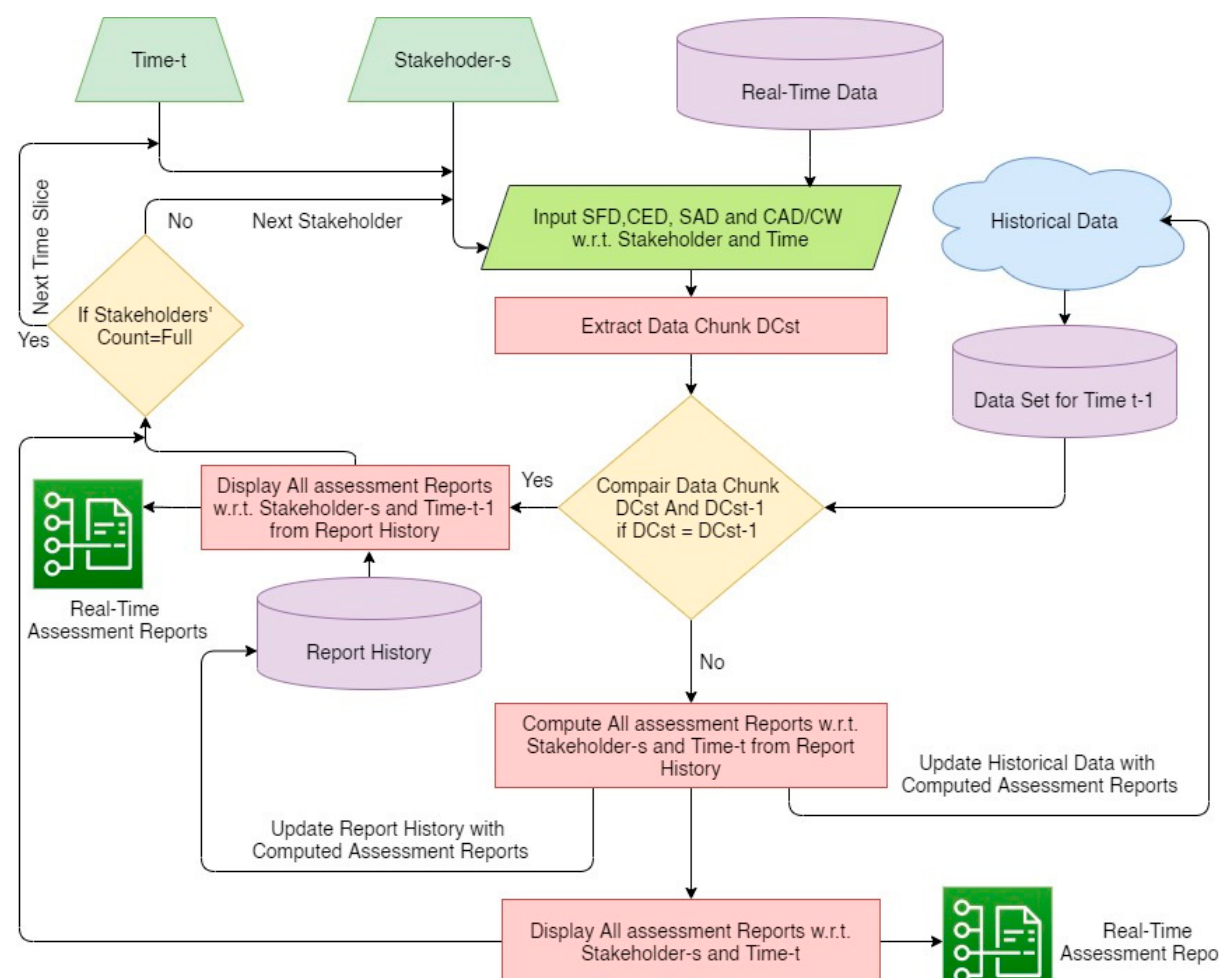
Figure 3. Real-time assessment under Education 4.0.